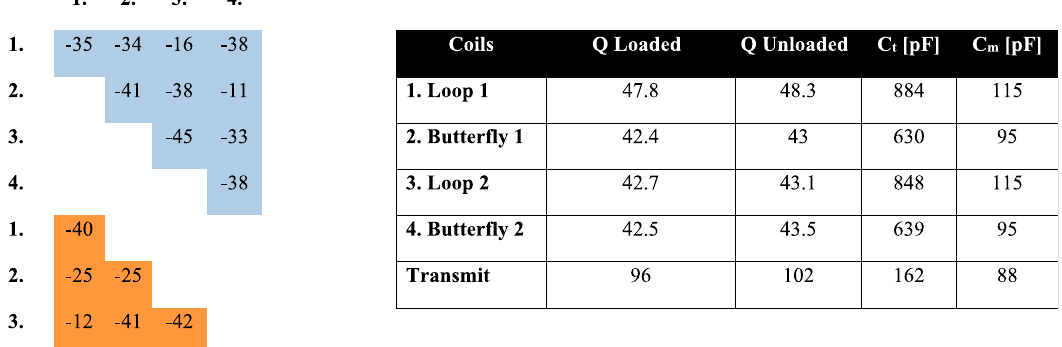
Frontiers in Physics |